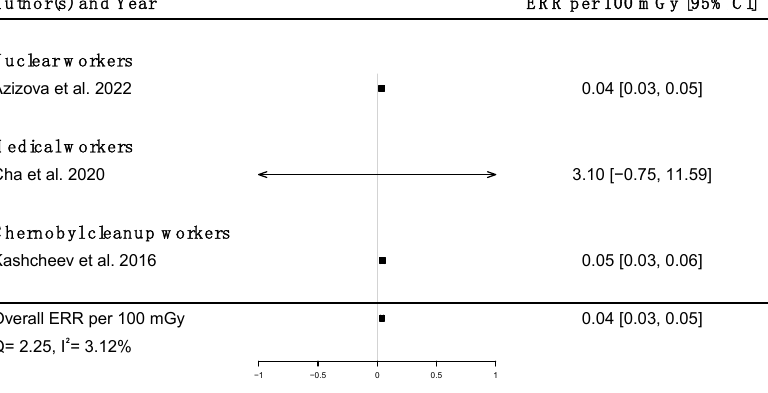
Figure 10. Excess relative risk (ERR) per 100 mGy and 95% confidence interval (CI) for morbidity from cerebrovascular diseases in relation to IR exposure.